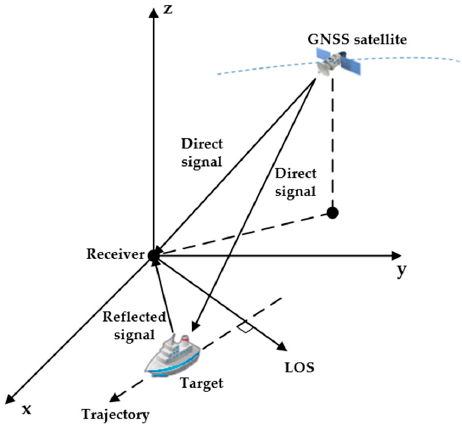
Figure 1. Bistatic acquisition geometry with a stationary receiver and a global navigation satellite systems (GNSS) satellite.